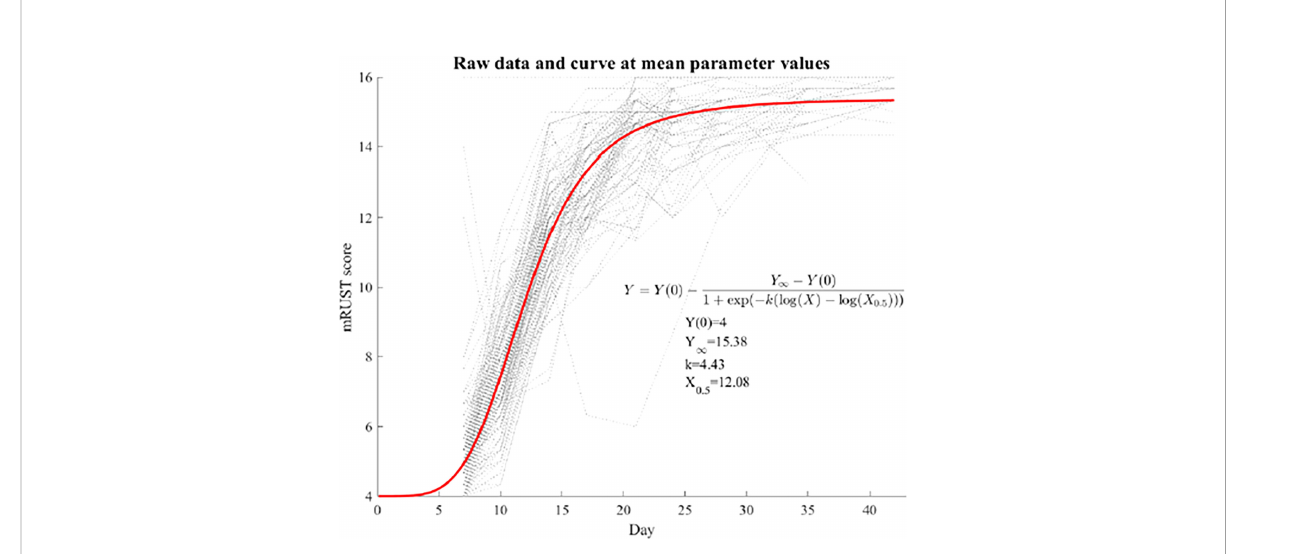
FIGURE 3 Fit log-logistic curve based on average mRUST scores over time. The underlying dotted curves represent each individual mouse ’ s healing trajectory.